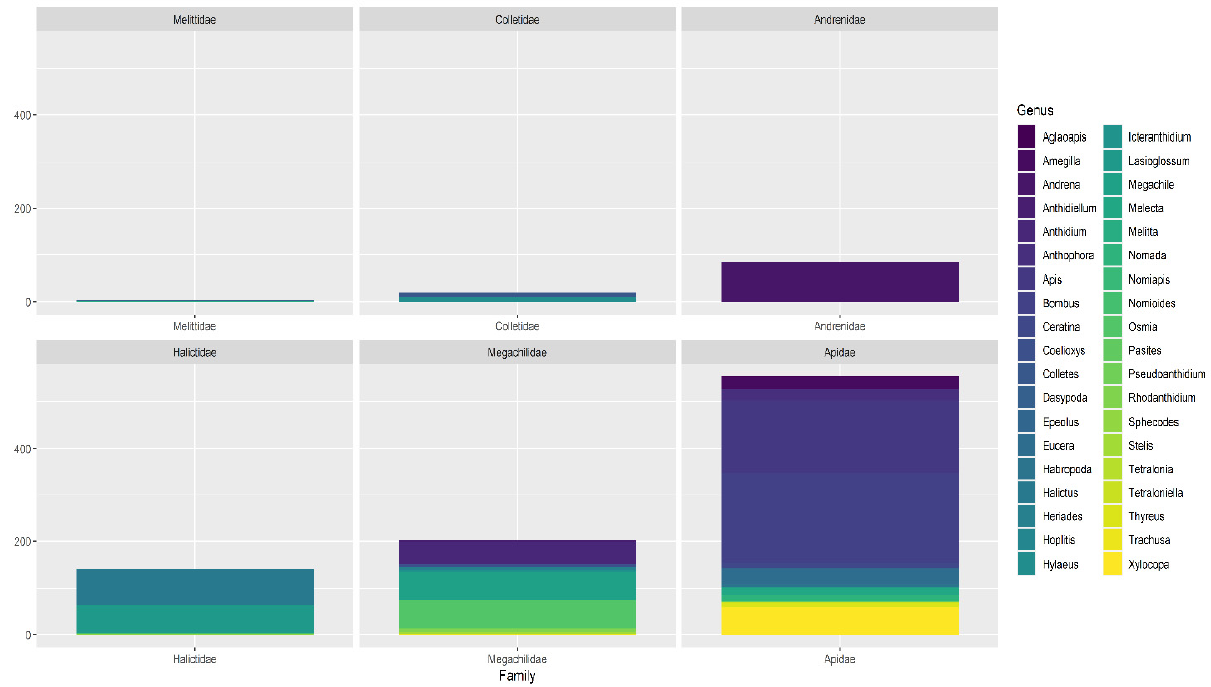
Figure 5. Reported specimens grouped by genus and family .